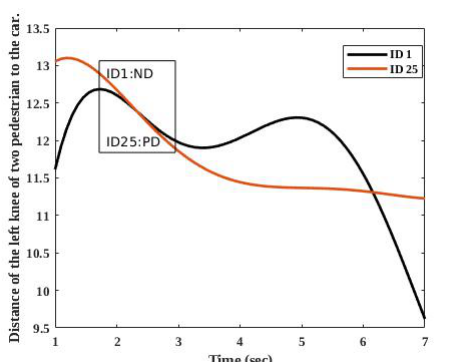
Figure 11. The result of the tracking two pedestrians in the sequences number 15 of the KITTI tracking benchmark. The vertical axes of the figure is the displacement of the pedestrians to a standing car. In the figure, ND means no detection and PD indicates partial